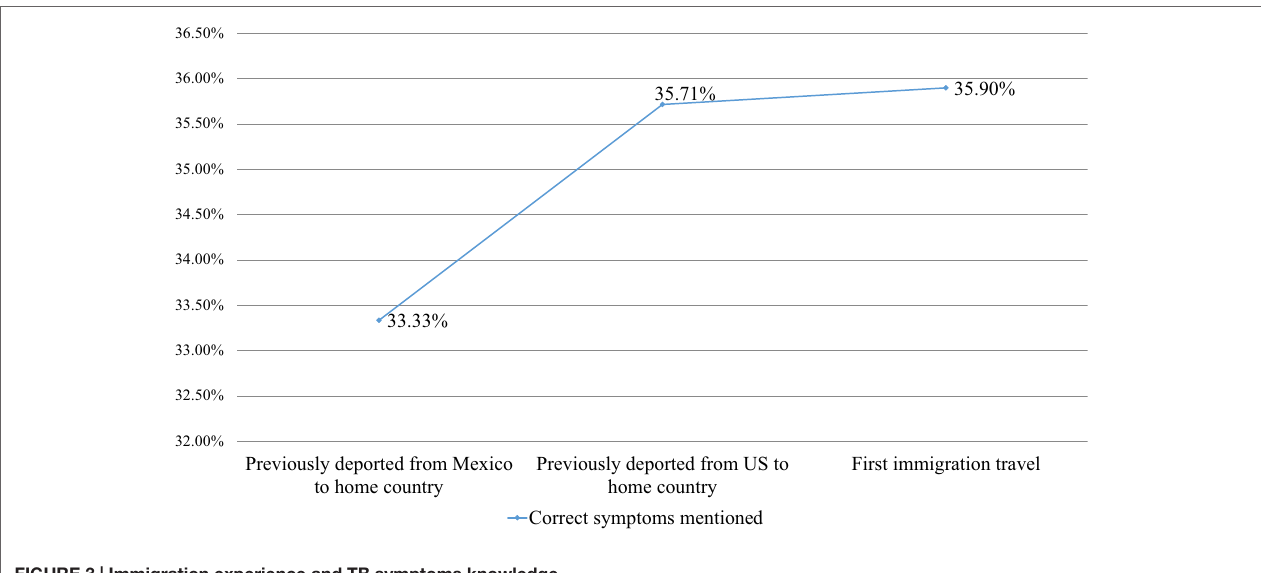
FigUre 3 | immigration experience and TB symptoms knowledge